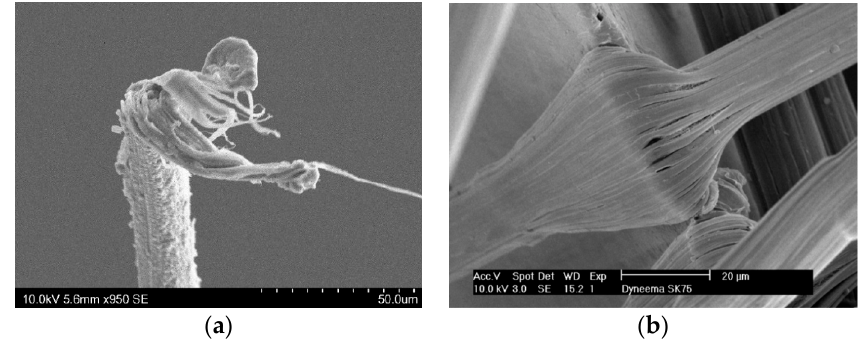
Figure 3. ( a ) Failure of an SK76 filament (note individual softening and drawing of fibrils); ( b ) SK76 filament over a razor blade (reproduced from Reference [18]). Note debonding of individual fibrils.